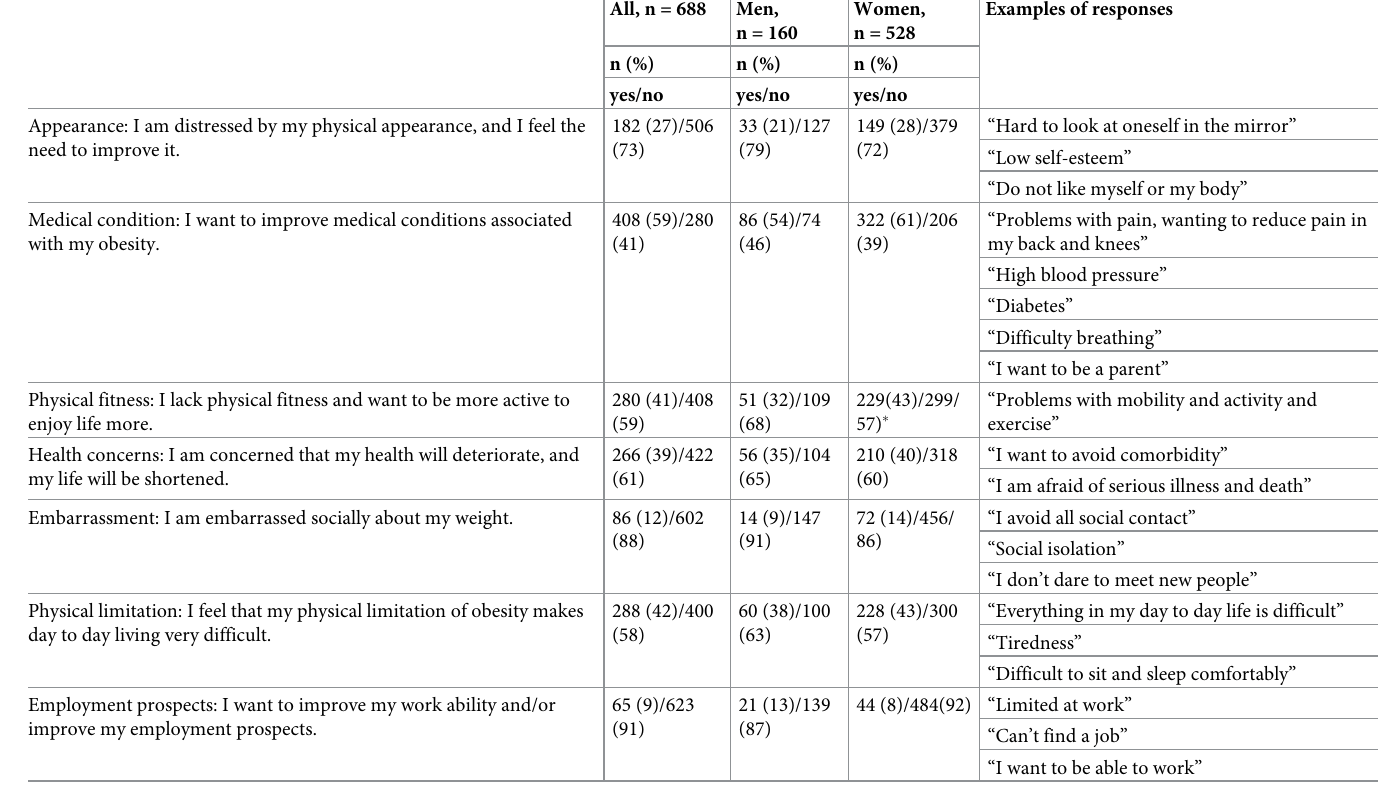
Table 2. Reasons for undergoing surgery for the whole sample and for men and women